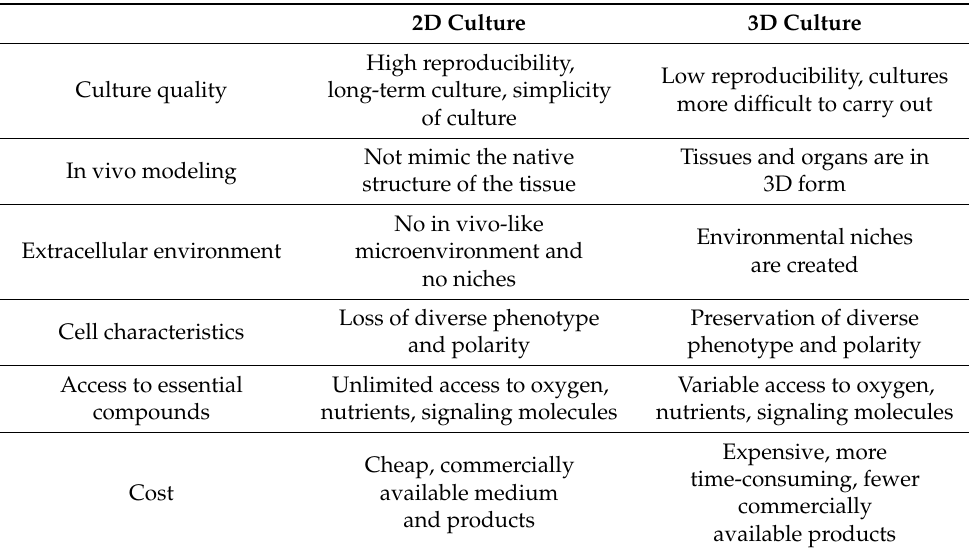
Table 4. Comparison of 2D and 3D cell culture